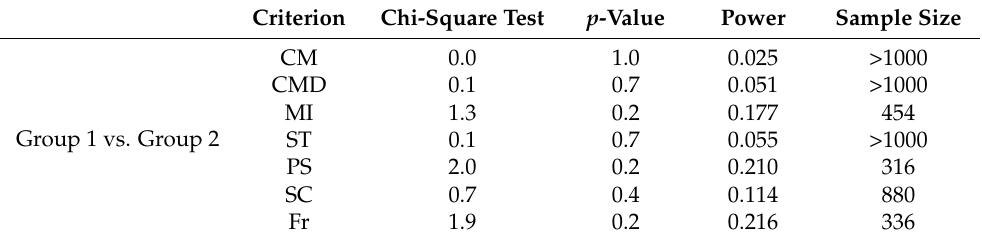
Table 3. Results of a log-rank test for comparing long-term results after DCR between two groups: those with the absence of biological factors of caries risk (Group 1) and the presence of biological factors of caries risk (Group 2).